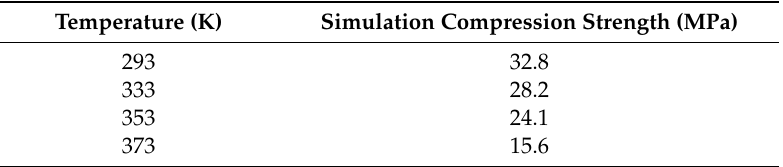
Table 3. Compression strength of PBX at di ff erent